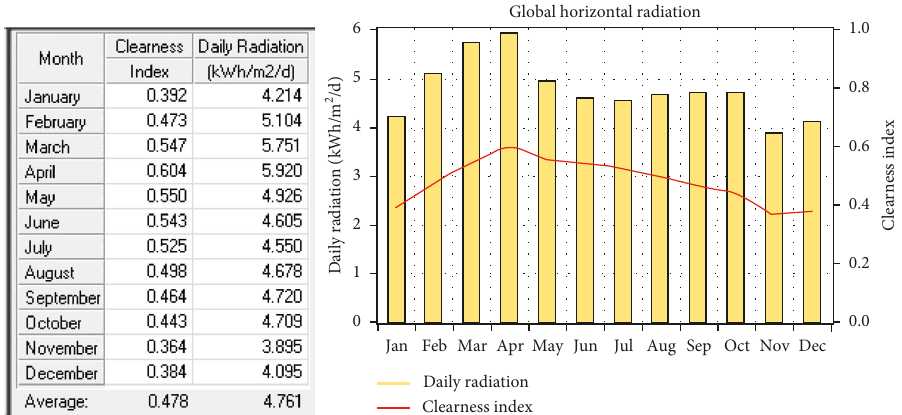
Figure 16: Average monthly solar radiation on horizontal surfaces in Magelang district, Central Java province,